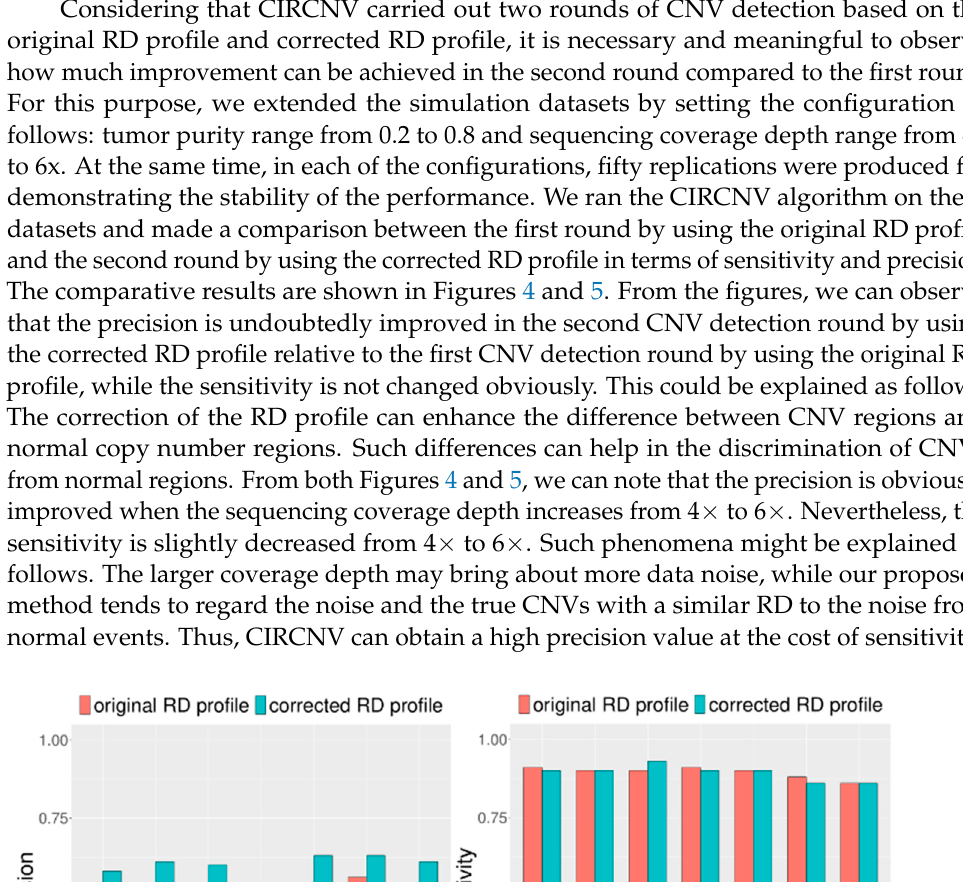
. Figure 5. Performance comparisons between the first-round (using original RD profile) and the second-round (using corrected RD profile) CNV detected by the CIRCNV method with respect to sensitivity and precision. The simulation tumor purity ranges from 0.2 to 0.8, and the sequencing coverage depth is 6×. 3.2. Detection of Copy Number Variants from Breast Cancer Sample To further validate the performance of the CIRCNV method, we applied it to analyze three real sequencing tumor samples on a whole genome. These samples were down- loaded from the European Genome-phenome Archive (EGA) data project at (https://ega- archive.org/, accessed on 9 June 2021). These samples were sequenced from ovarian cancer patients numbered with EGAR00001004802_2053_1 and EGAR00001004836_2561_1, and one lung cancer patient numbered with EGAD00001000144_LC. We performed the CIRCNV method on the whole genome including twenty-two au- tosome chromosomes and compared it to three peer methods, FREEC, CNVnator, and CNV-LOF. The comparative results are shown in Figures 6 and 7 for the three samples. These figures show the number of declared CNVs in each of the autosome chromosomes. We can notice that CNVnator obtains the largest number of CNVs, followed by CIRCNV, CNV-LOF, and FREEC. However, the number of declarations cannot account for the mer- its of the methods. Due to the lack of answers in real tumor samples, it is not easy to esti- mate the sensitivities and precisions for the methods. Instead, we use Venn diagrams to describe the overlapping among different methods in Figures 6 and 7 for the two samples.